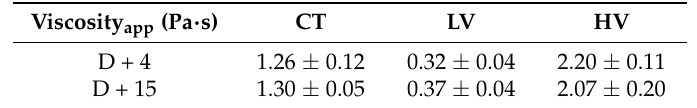
Table 2. Apparent viscosity of the three yogurts measured 4 days (D + 4) and 15 days (D + 15) after